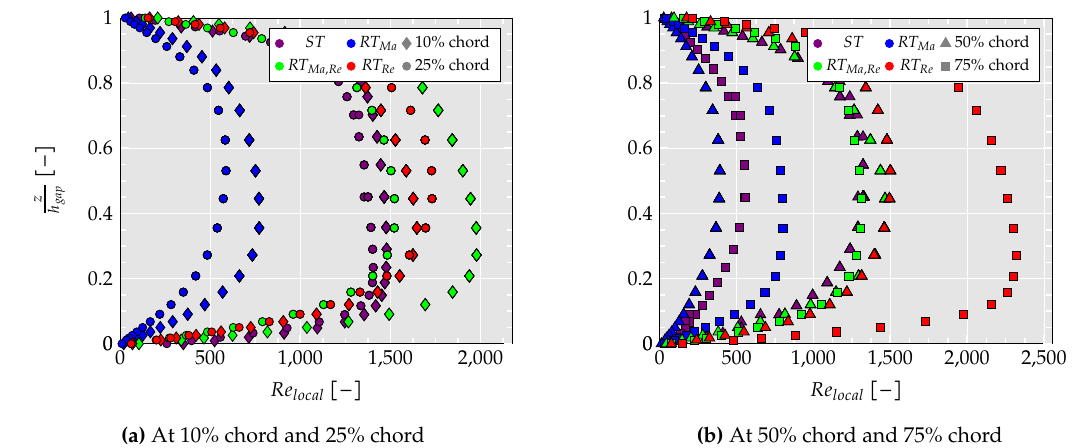
Figure 10. Local Reynolds number distribution in the tip gap.